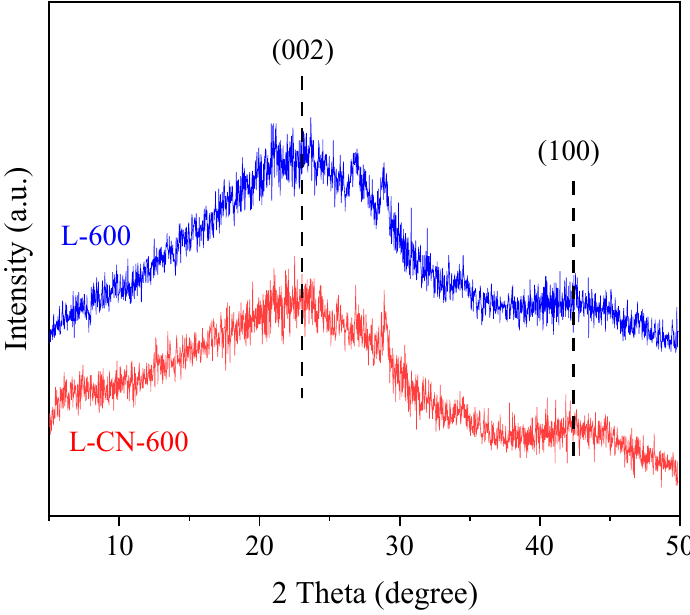
Figure 3. XRD patterns of L-600 and L-CN-600 samples. In order to obtain further confirmation on the structure of lignite-based carbon, Raman spectra of all samples were collected, as shown in Figure 4. All samples show two distinct bands at 1588 (G-band, highly ordered graphitic structure) and 1340 cm − 1 (D-band, disor- dered structure), indicating that the lignite-based carbon materials are composed of highly ordered graphite and disordered structures, consistent with the XRD results. The intensity ratio of D-band to G-band (I D /I G ) is often used to estimate the degree of graphitization for carbon materials [40,41]. A higher value of I D /I G represents a lower graphitization degree with more disordered structures or topological defects. Figure 4 shows that the I D /I G value increases from 0.87 for L-500 to 1.02 for L-700, suggesting that the increase in activation temperature leads to a decline in graphitization degree. This phenomenon can be explained by the fact that a higher activation temperature causes a more serious decomposition of functional groups over the lignite-based carbon materials, thus generating more defects or disordered structures over the carbon